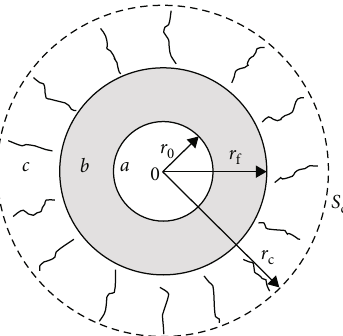
Figure 1: Diagram of the damage region in a con fi ned explosion: (a) cavity; (b) fracture region; (c) radial-crack